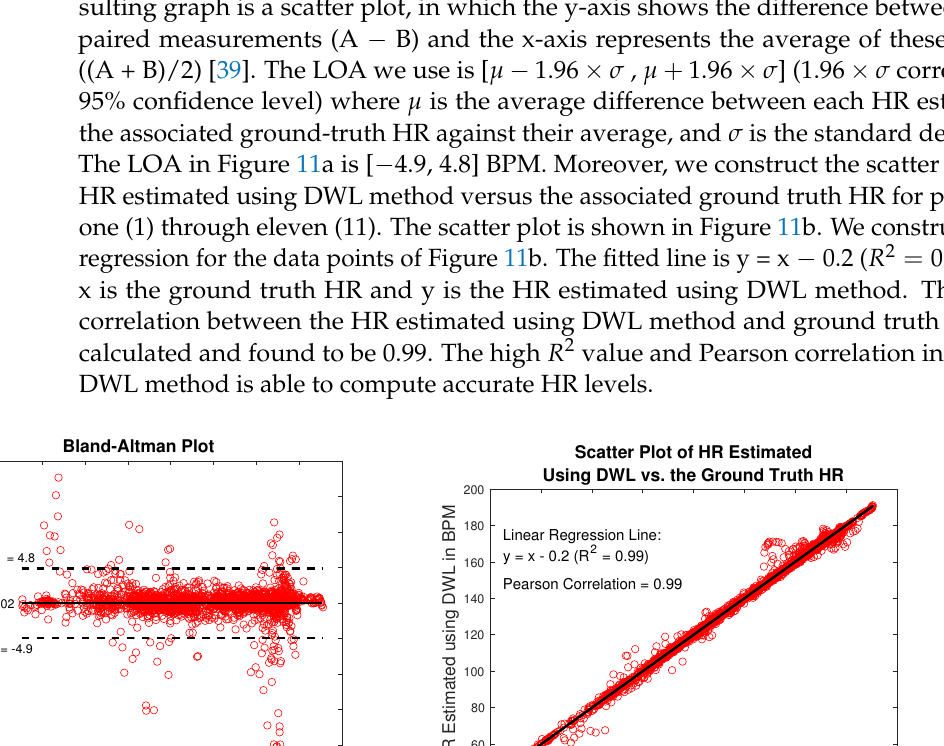
Figure 11. ( a ) Bland–Altman plot of HR estimated using DWL method and the ground truth HR for participants one (1) to eleven (11). The LOA = [ − 4.9, 4.8] BPM. ( b ) Scatter plot of HR estimated using DWL method (on the y-axis) vs. the ground truth HR (x-axis) for participants one (1) to eleven (11). The linear regression line that fits the data is shown in black. The line is y = x − 0.2 ( R 2 = 0.99). The Pearson correlation is found to be